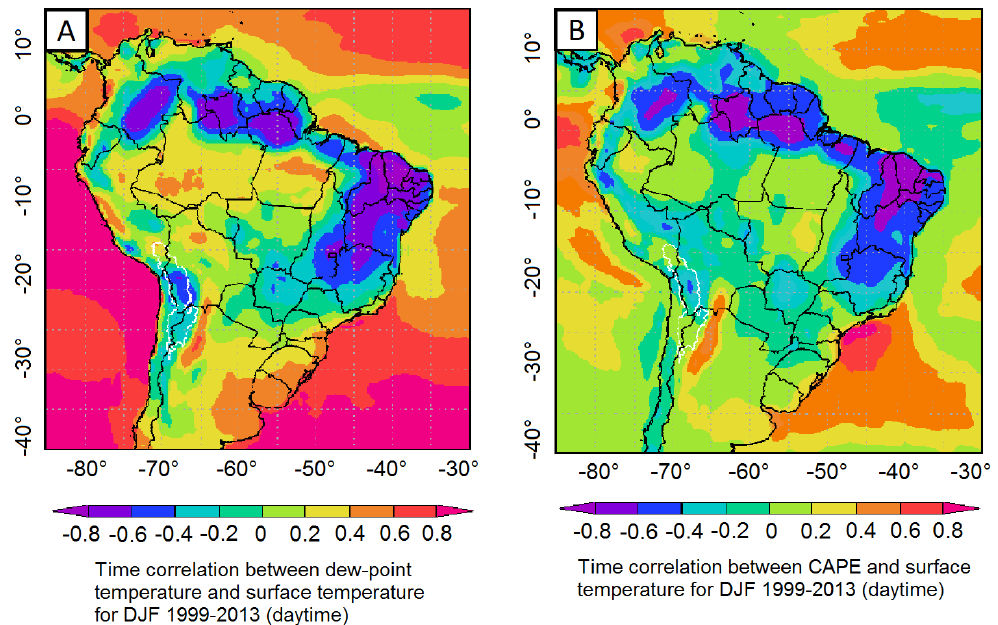
Figure 7. Lag-free temporal correlation between dew-point temperature and surface temperature ( A ) and between convective available potential energy (CAPE) and surface temperature ( B ) during the austral summer and during the daytime (6 a.m.–6 p.m. local time) (1999–2013) based on ERA-interim reanalysis data. A high correlation coefficient suggests that both climatic variables and surface temperature are correlated eastward of the south–central